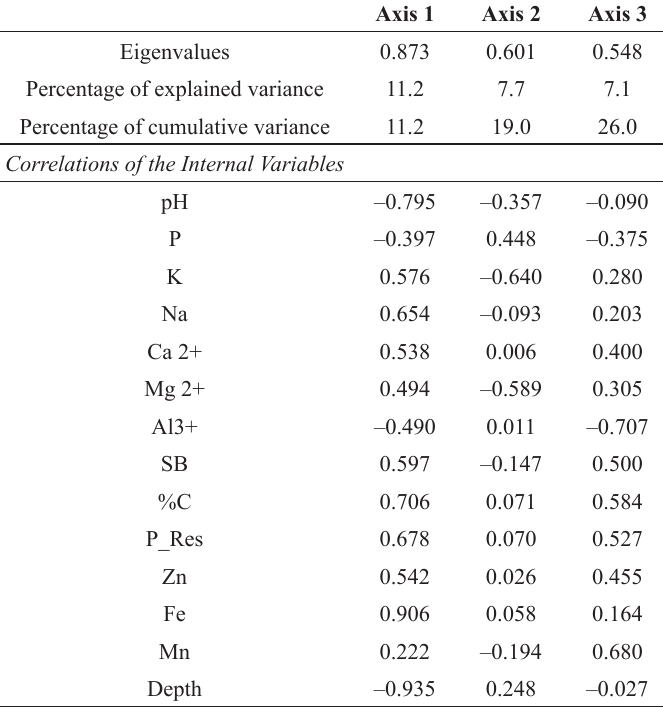
Summary of canonical correspondence analysis (CCA) of plant species coverage and soil properties for the studied rocky outcrops on lateritic canga at Serra Sul, Serra dos Carajás, state of Pará,